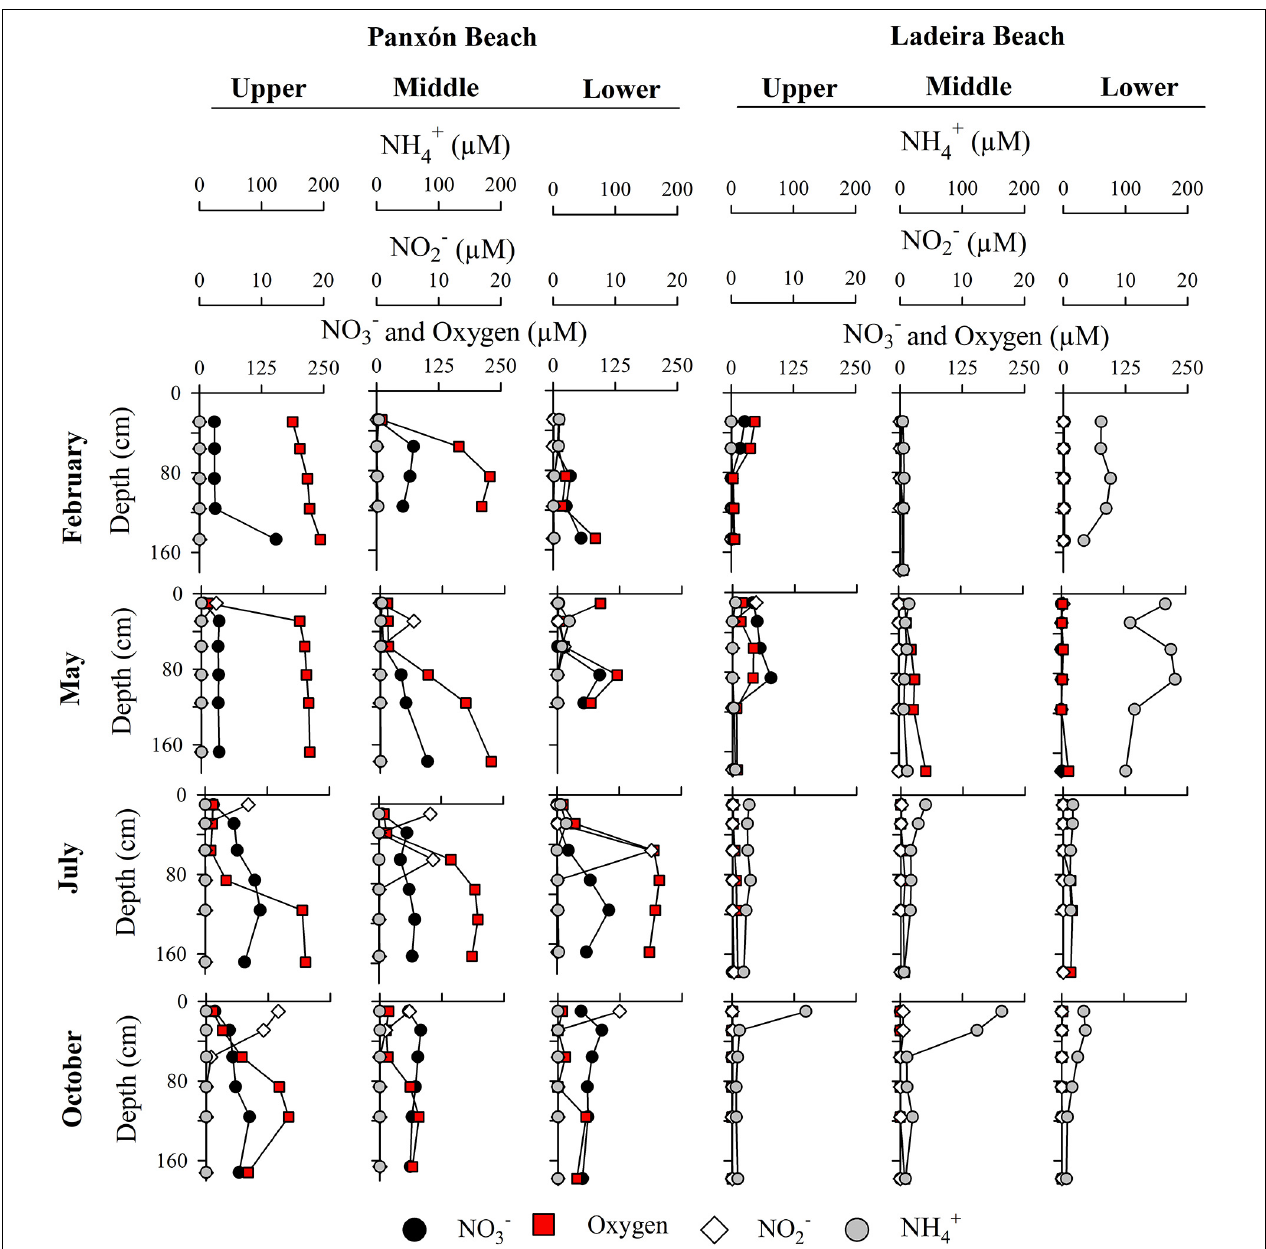
FIGURE 5 | Vertical porewater profiles of nitrate (NO 3 - ), nitrite (NO 2 - ), ammonium (NH 4 + ) and dissolved oxygen concentrations (in µ M) organized by sampling station, month and beach.